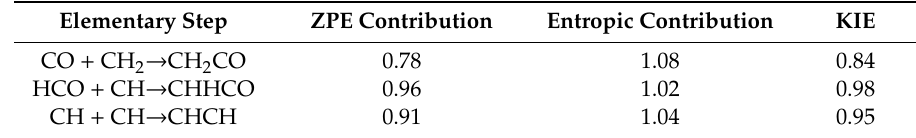
Table 7. The kinetic isotope e ff ect at 500 K for three possible coupling